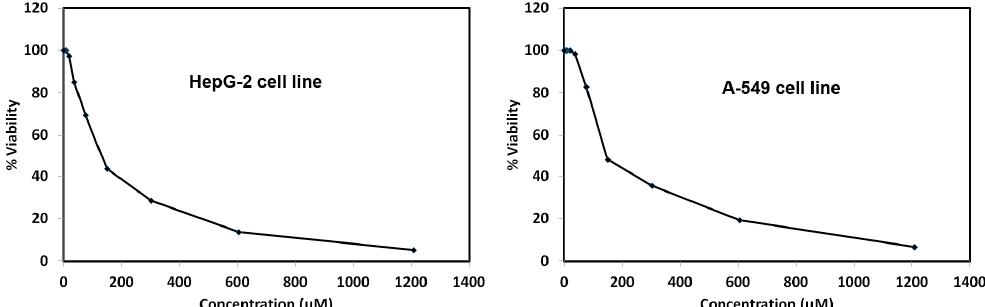
Figure 5. Cell viability assay for the cytotoxic activity of the studied Ni(II) complex against hepatocellular (HepG-2) and lung (A-549) carcinomas.